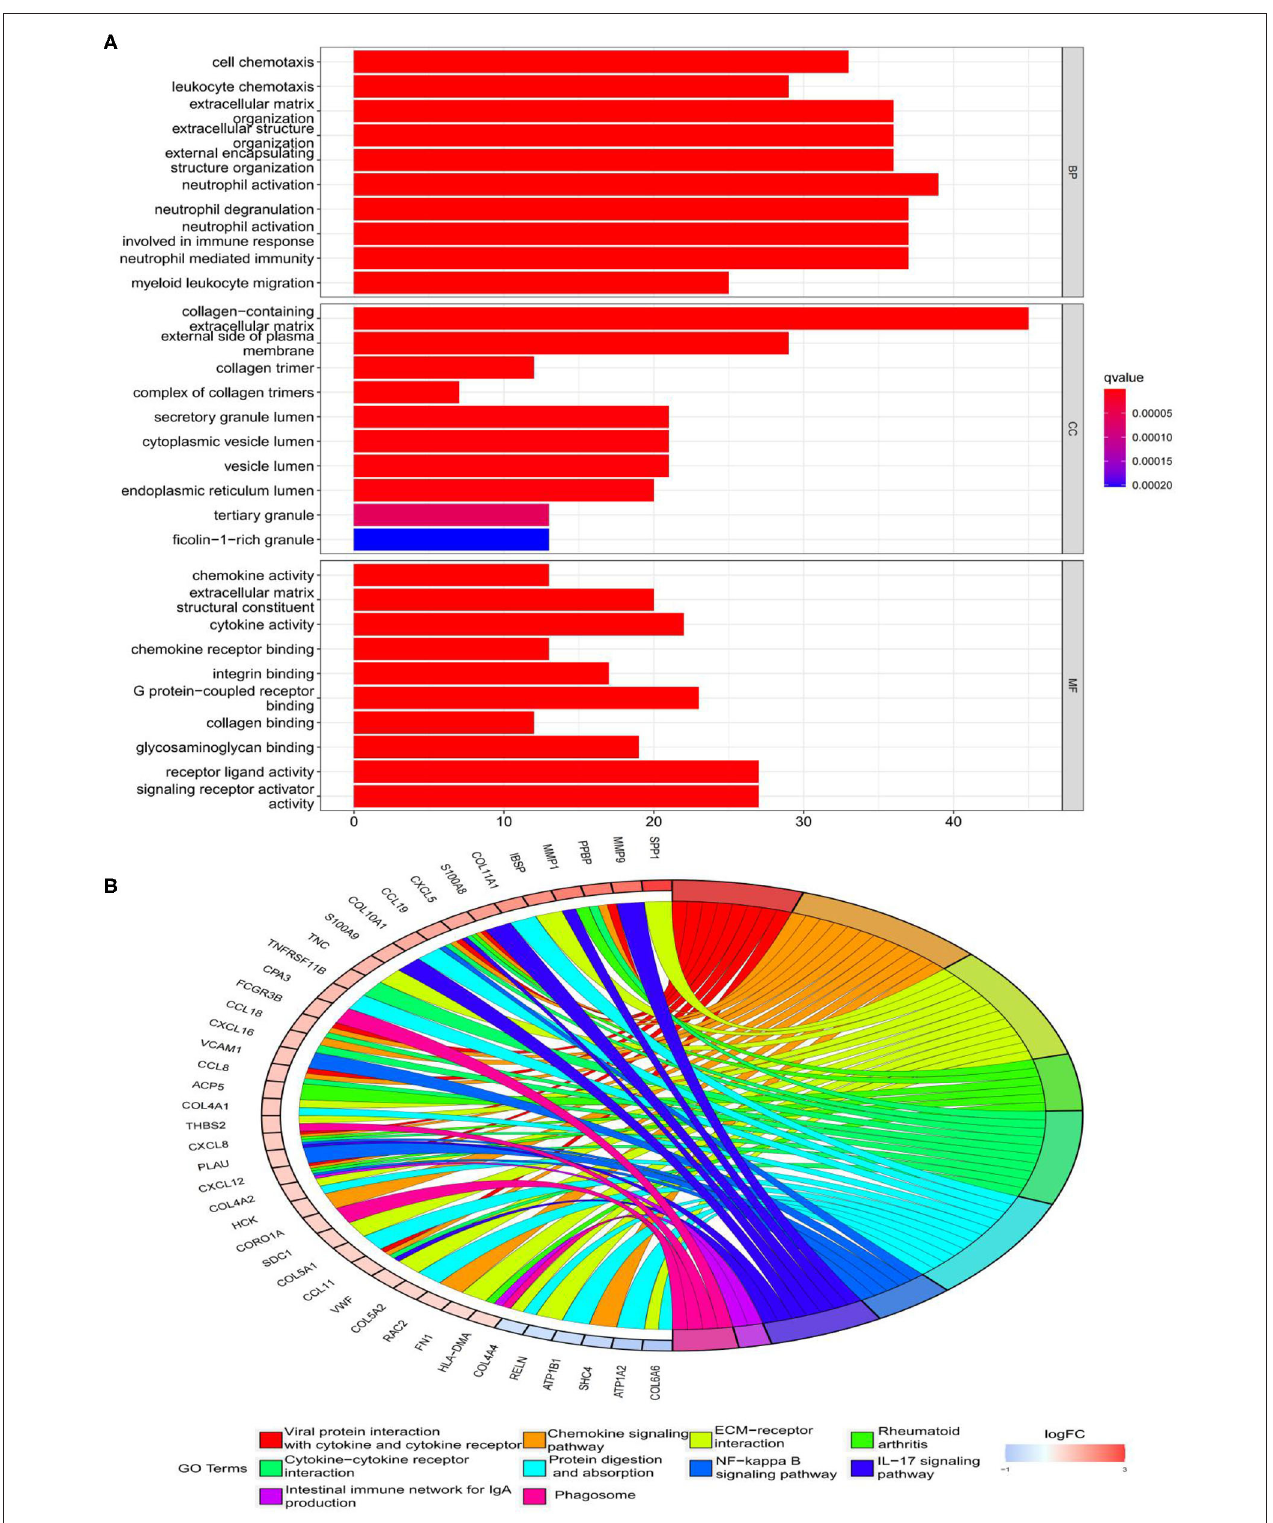
FIGURE 3 | Functional enrichment analyses of DEGs. (A) Gene Ontology (GO) enrichment analyses of DEGs. The x-axis shows the number of genes enriched on the terms, and the y-axis shows the pathway terms. The q-value of each term is colored according to the legend. BP, biological process; CC, cellular component; MF, molecular function; (B) Kyoto Encyclopedia of Genes and Genomes (KEGG) enrichment analyses of DEGs. Select the first 30 DEGs to connect to the enriched pathway terms. The q-value of each term is colored according to the legend. The different colors represent different pathway terms.